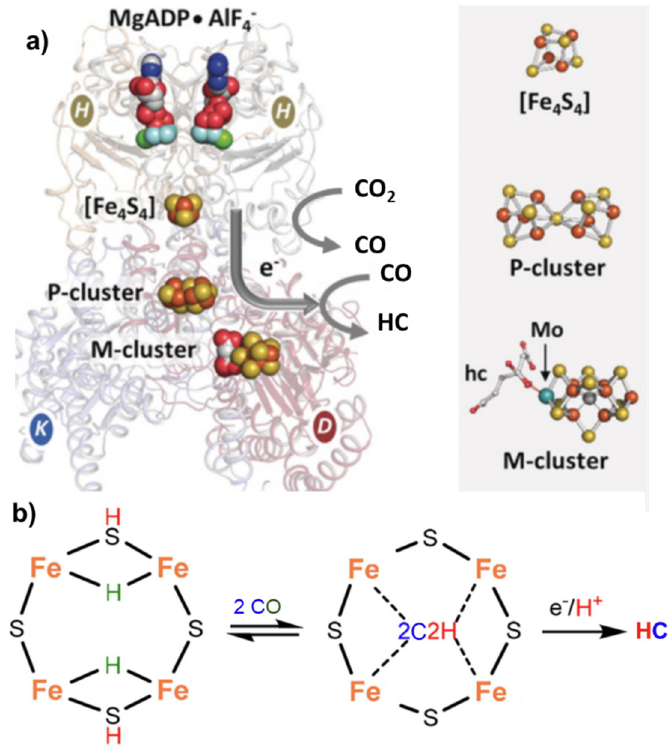
Figure 3. ( a ) Nitrogenase enzyme with indications of the key components involved in electron transfer, including MgADP AlF 4 − , [Fe 4 S 4 ] cluster, P-cluster and M-cluster with indication of the active centers involved in CO 2 to CO and CO 2 to hydrocarbon (HC) conversion. Adapted from [28]. Copyright 2016 Wiley. ( b ) Proposed schematic mechanism of the active sites in FeMo cofactor (M-cluster) for conversion of CO to HC.